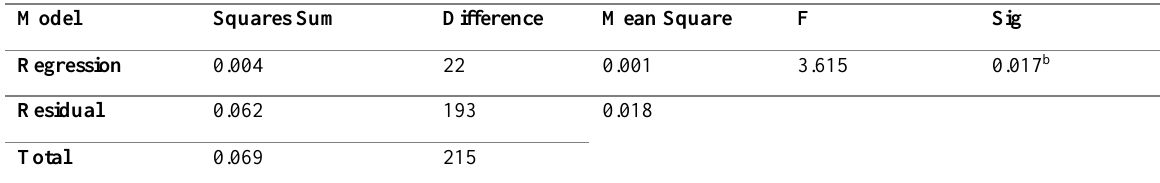
Table 9: ANOVA Test